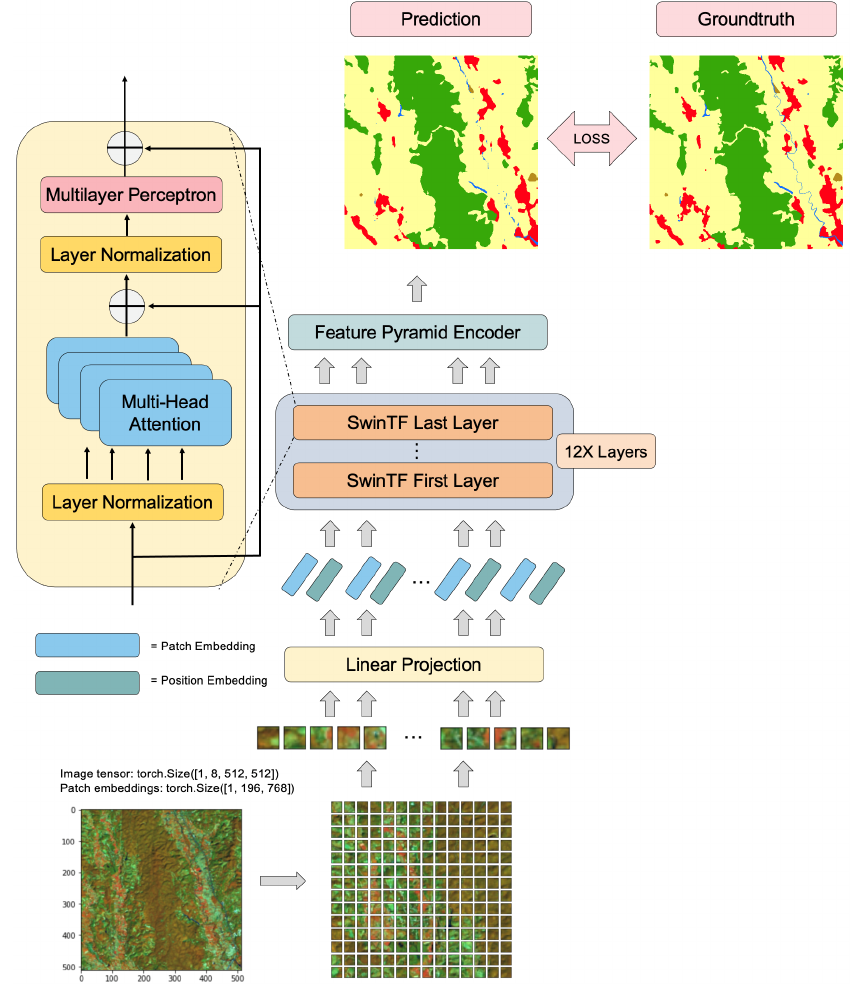
Figure 2. The architectural structure of our proposed